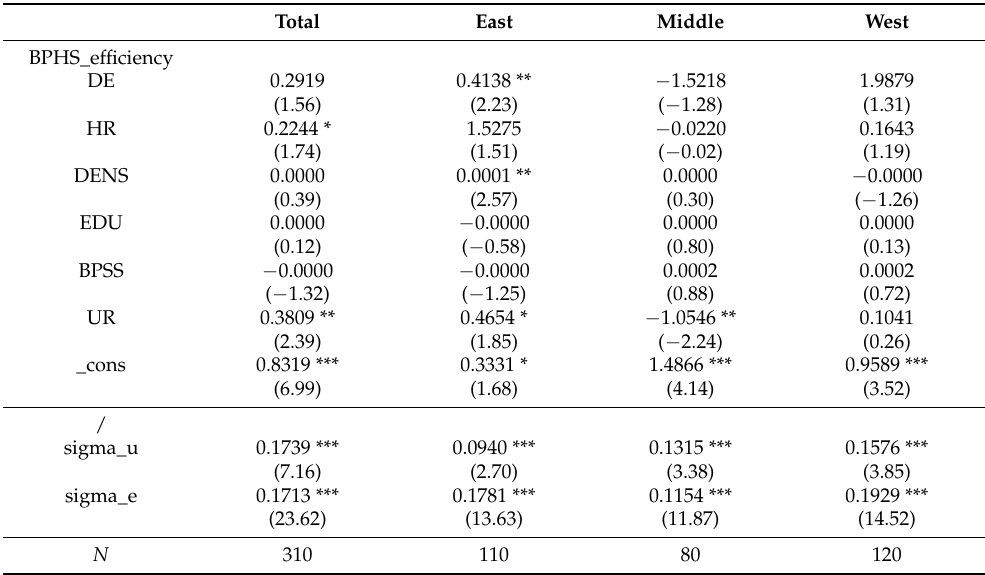
Table 8. Tobit model estimation of the impact of the digital economy on public health efficiency.